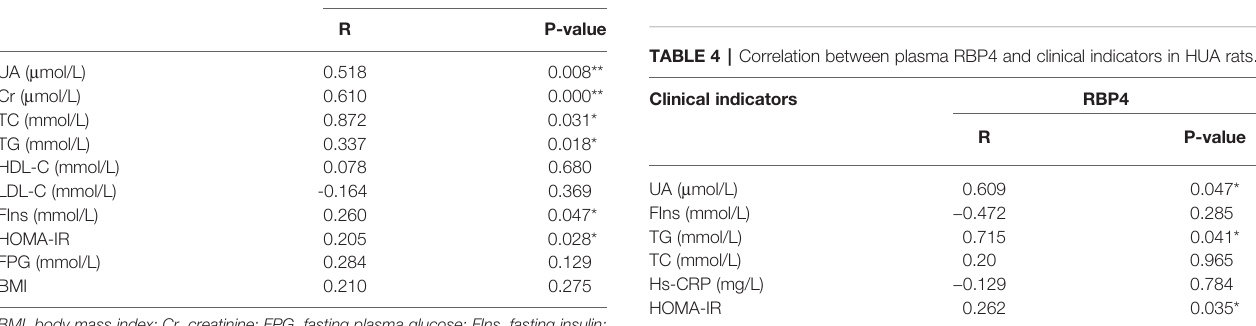
TABLE 2 | Correlation between plasma RBP4 and clinical indicators. Clinical indicators